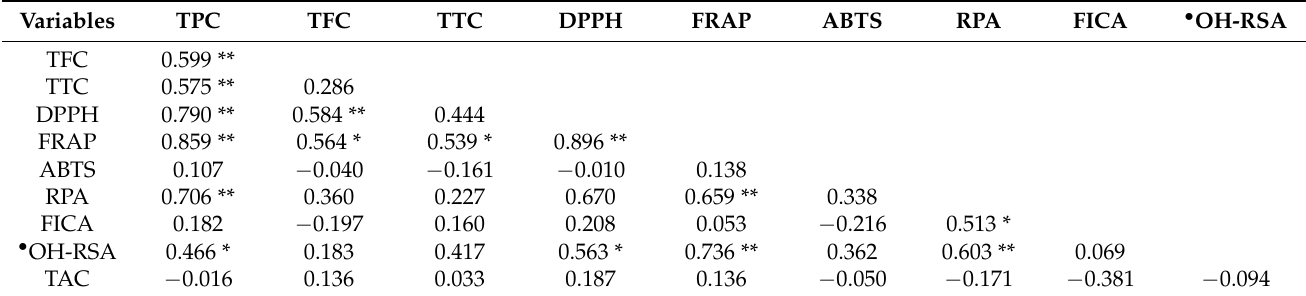
Table 3. Pearson’s linear correlation between banana phenolic content and their antioxidant capacity.